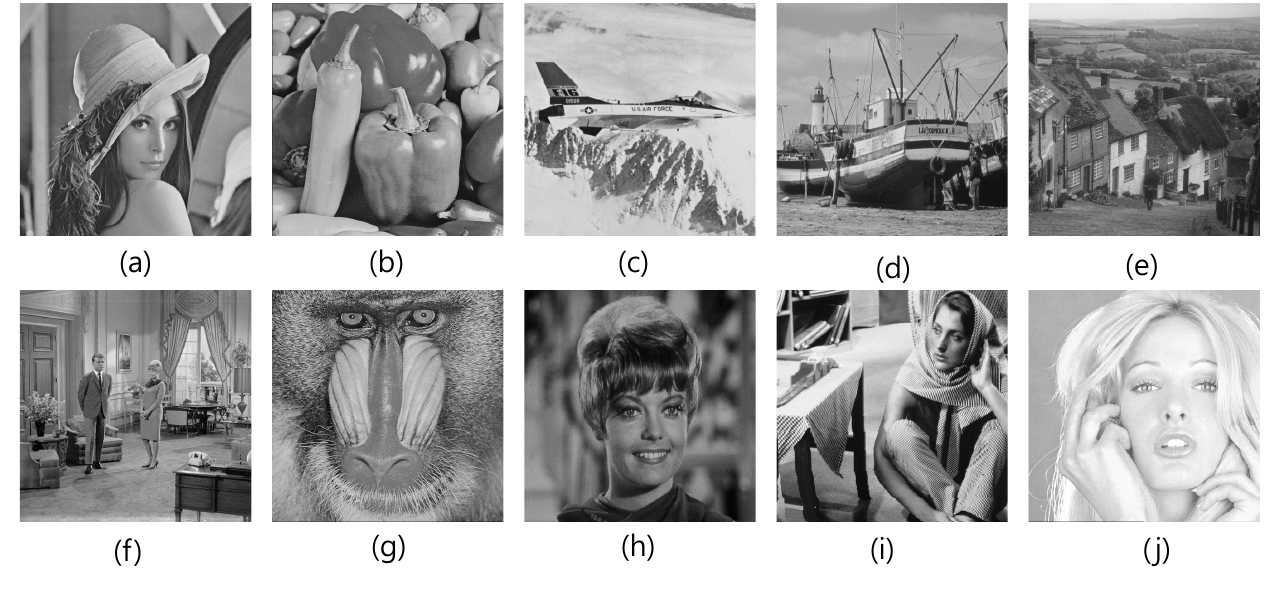
Figure 5. Test images: ( a ) Lena, ( b ) Peppers, ( c ) Airplane, ( d ) Boat, ( e ) Goldhill, ( f ) Couple, ( g ) Baboon, ( h ) Zelda, ( i ) Barbara, ( j ) Tiffany ( 512 × 512 )